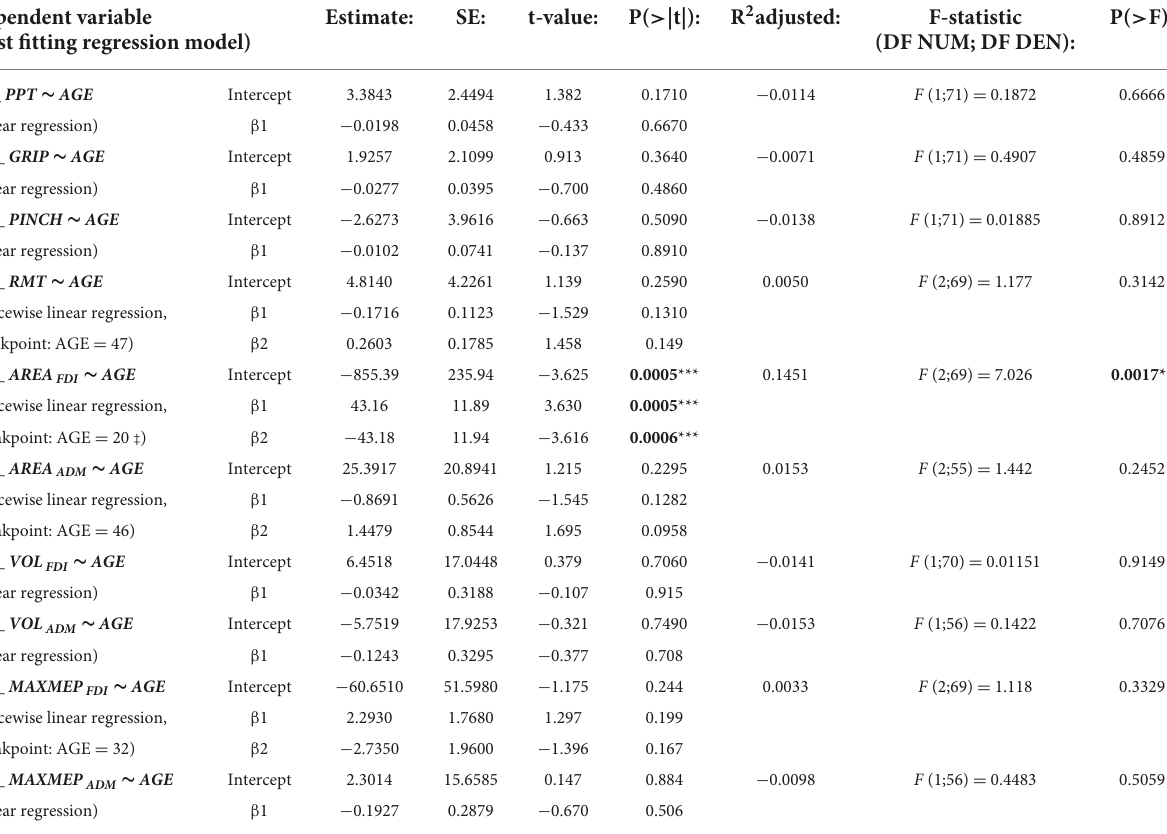
TABLE 4 Point estimates, standard error (SE) and statistics for regression models for lateralization quotients [LQ = (R-L)/(R + L)] with AGE as independent variable. Dependent variable (best fitting regression